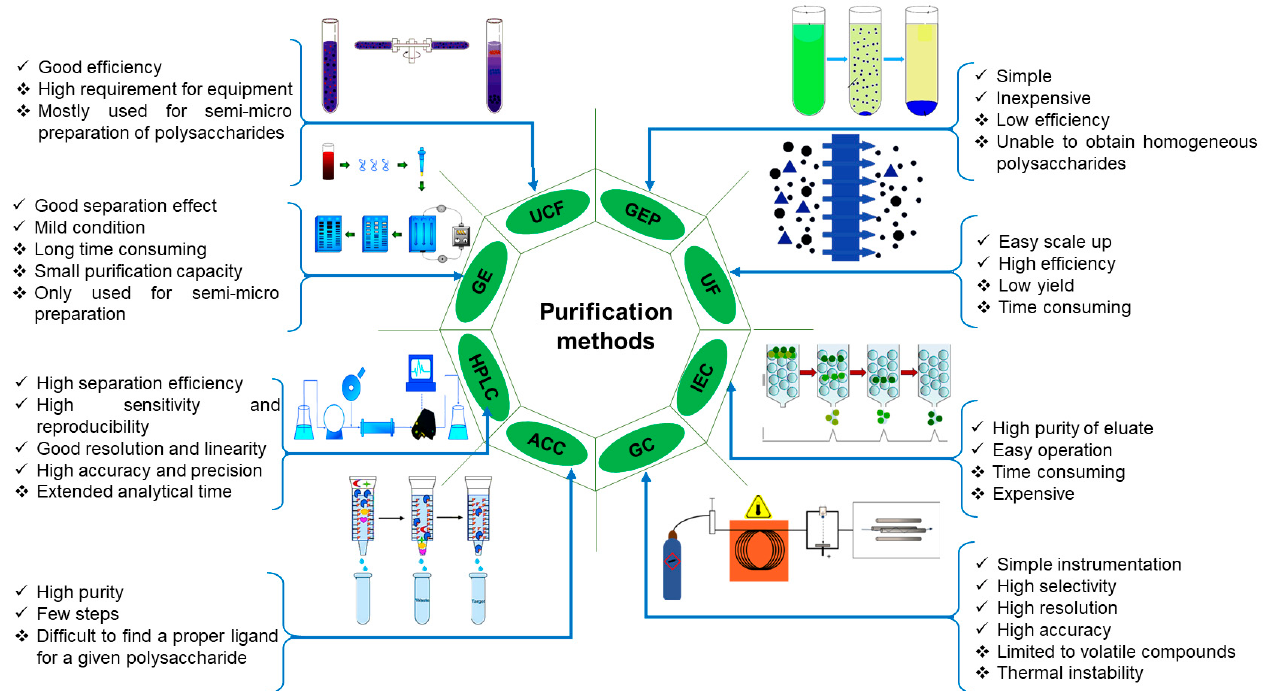
Figure 3. Purification methods comparisons in terms of advantages and disadvantages. UCF, Ultracentrifugation; GE, Gel electrophoresis; HPLC, High-performance liquid chromatography; ACC, Affinity column chromatography; GC, Gas chromatography; IEC, Ion exchange column chromatography; UF, Ultrafiltration; GEP, Gradient ethanol precipitation.